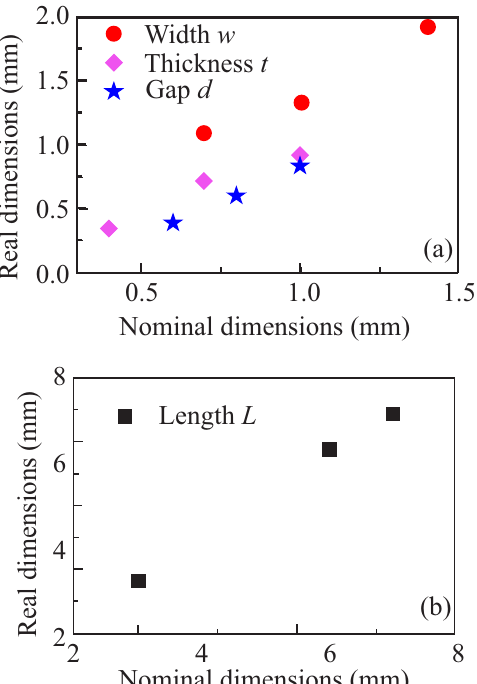
Figure 2. Measured versus nominal dimensions for PLA/Ag epoxy 3D printed SRRs, regarding ( a ) the width w (red circles), the thickness t (magenda rhombs) and the gap size d (blue stars) of the SRR while panel. ( b ) The corresponding values for the SRR length L